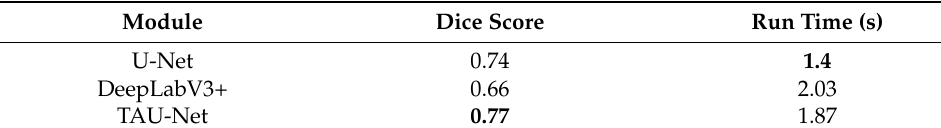
Table 1. The segmentation results of TAU-Net on the poppy dataset. The segmentation evaluation values represent the average of 5 experiments. Besides, Table 1 also contains the results of U-Net and DeepLabV3+ comparing experiments on the same dataset.